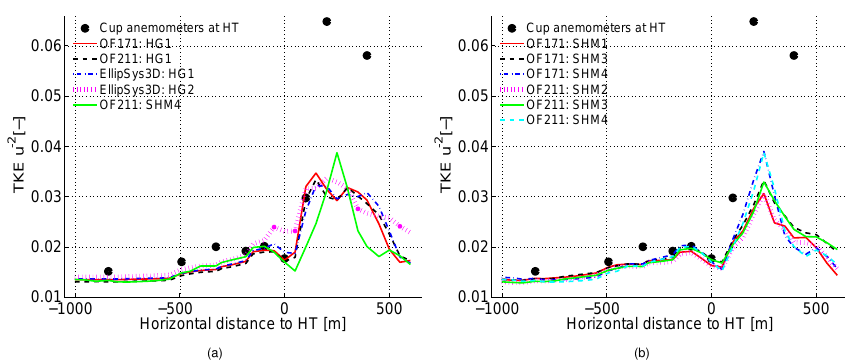
Figure 5. Askervein Hill: turbulent kinetic energy along the line A.